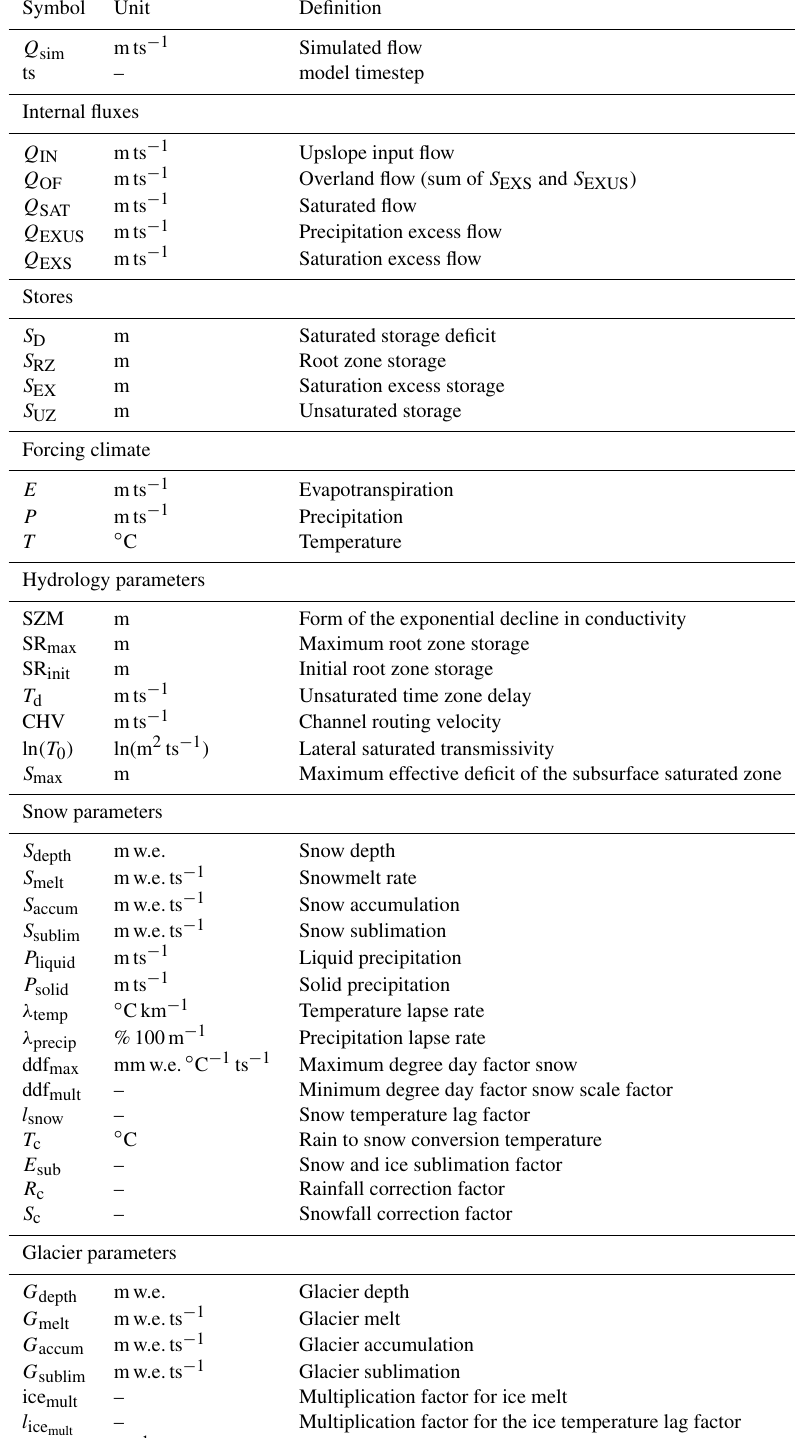
Table A1. Definition of symbols shown in Fig.